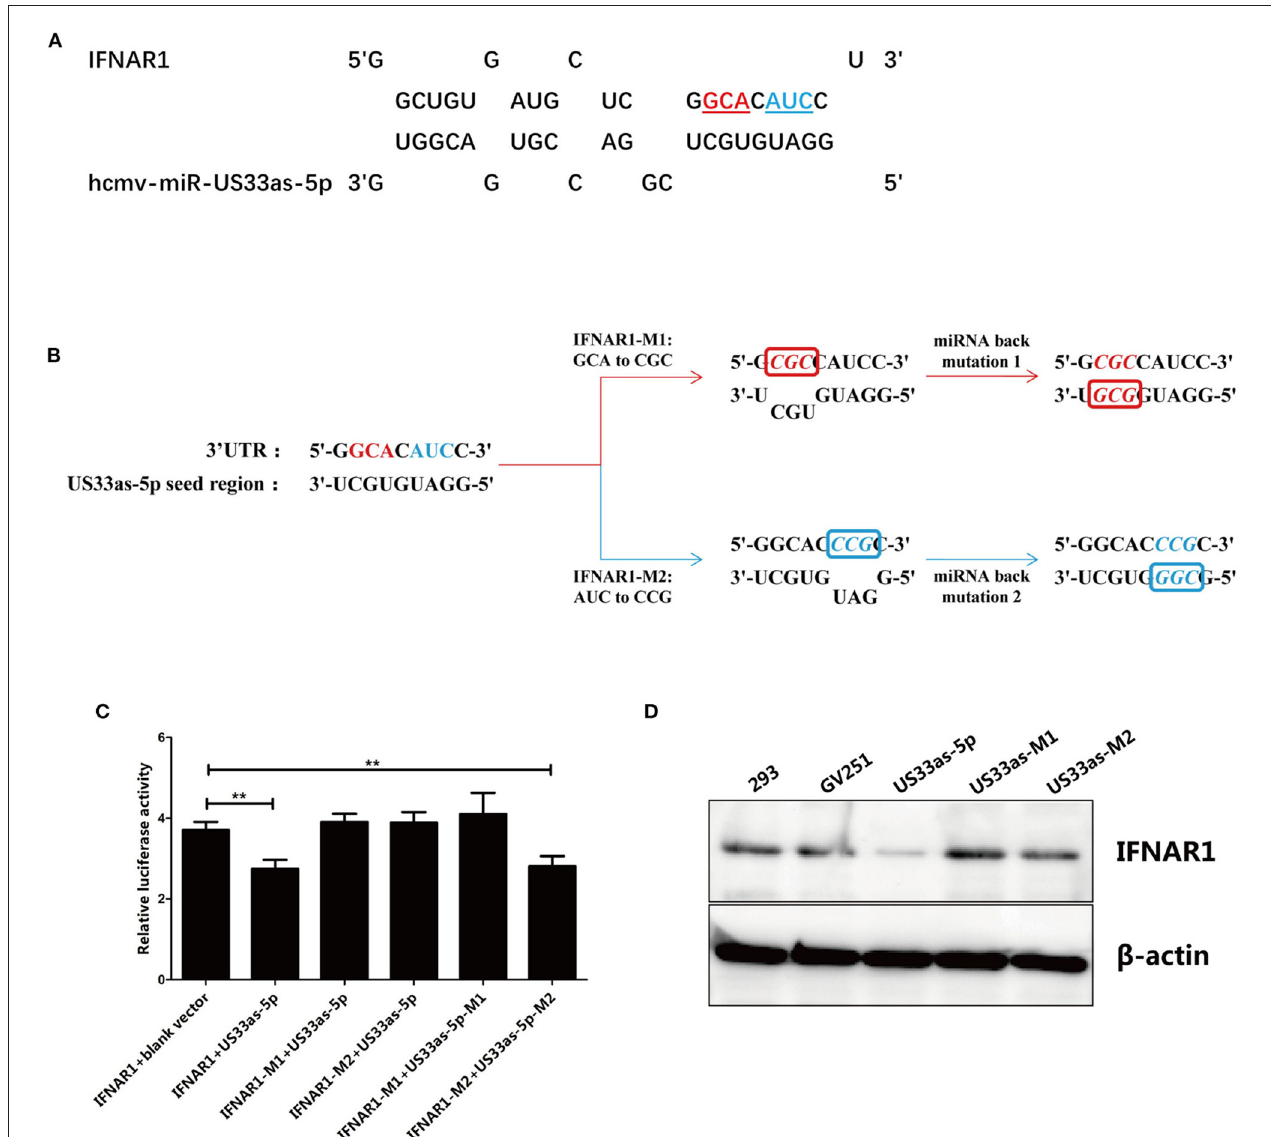
FIGURE 2 | Main binding site in hcmv-miR-US33as-5p for IFNAR1 mRNA. (A) Schematic of the targeting of IFNAR1 by hcmv-miR-US33as-5p. Mutated nucleotides are shown in color and underlined. (B) Mutation of the IFNAR1-binding site and back mutation of the hcmv-miR-US33as-5p seed region. For IFNAR1 mutagenesis 1, GCA was mutated to CGC, and the miRNA was complementarily mutated to GCG for miR-US33as-5p back mutagenesis 1. For IFNAR1 mutagenesis 2, AUC was mutated to CCG, and the miRNA was complementarily mutated to CGG for miR-US33as-5p back mutagenesis 2. The pmirGLO-IFNAR1-Mutation-UTR vector and GV251-US33as-Mutation-UTR vector were co-transfected into 293 cells cultured in 24-well plates. (C) Dual-luciferase reporter assays to determine relative firefly luciferase activity in 293 cells co-transfected with pmirGLO-IFNAR1-Mutation-UTR vector and GV251-US33as-Mutation-UTR vector were performed, and the calculated data are shown in Figure 1A . (D) Western blot showing the expression of IFNAR1 in 293 cells co-transfected with pmirGLO-IFNAR1(-Mutation)-UTR vector and GV251-US33as(-Mutation)-UTR vector harvested at the same time, with β -actin used as a loading control. The assays were performed in triplicate wells, and data were collected from two different experiments and are represented as the means ± SDs; ** p <